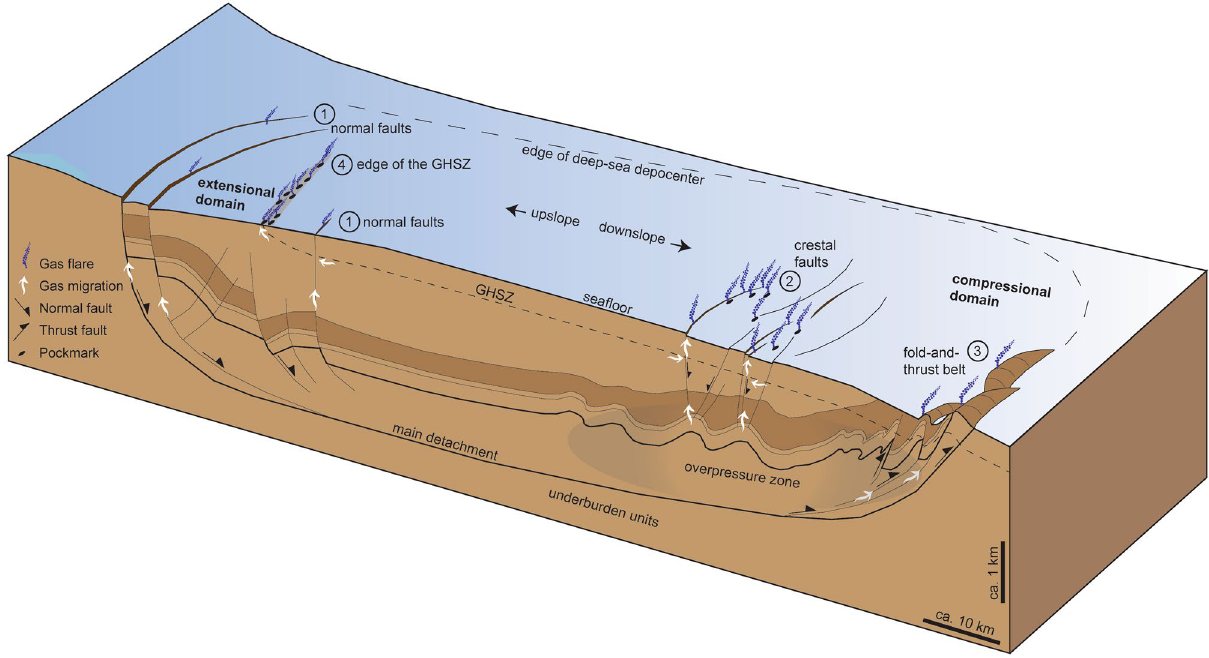
Figure 8. Schematic diagram summarising the probable loci of seafloor methane release associated with the gravitational collapse of sediment-laden continental slopes. Methane leakage occurs in both the extensional and compressional domains, preferentially at the intersection of the following structures with the seafloor: (1) listric normal faults in the extensional domain, (2) crestal faults on top of folds and (3) thrust and related strike- slip faults in the compressional domain. Another potential locus for seafloor methane emission, not related to gravitational collapse, is (4) the feather edge of the gas hydrate stability zone (GHSZ). The figure was elaborated in Adobe Illustrator (version 26.0.1; https:// www. adobe. com/ illus quantified by inspecting the video records and counting the number of bubbles venting out from the seafloor per unit of time 37 . The calculations assume no temporal variability of advective flux on timescales longer than the observed time (ca. 1 h). Measured bubble diameter was 0.5 cm and the quantity of methane n (moles) in each bubble was calculated based on the universal gas law (n = PV/ZRT), where P is pressure (13.5 MPa), V is the bub- ble volume (0.065 cm 3 ), Z is the compressibility of methane (0.7426) calculated by the Peng − Robinson equation of state 69 , R is the gas constant, and T is the bottom water temperature (3.25 °C). The mass of methane in each bubble was calculated based on the number of moles (obtained from the universal gas law) and the molar weight of methane. The emissions were then estimated based on the number of bubbles per unit of time. The bottom water temperature and pressure were obtained from a conductivity, temperature, depth (CTD Sea-Bird Electron- ics SBE 911plus) profile acquired in the area near PC83 (see Supplementary Data 3 and Fig. 4a for location). The CTD (temperature) data was also used to calculate the depth of the upper limit of the methane hydrate stability zone in the water column using the equilibrium equation of pure methane in seawater 70 . Chemical and isotopic composition of gas. Sediment samples (ca. 200 cm 3 ) were collected every 1.5 m in all piston cores for gas analyses. Samples were placed in gas-tight containers (Isojars), together with 200 cm 3 of distilled water and 10 drops of Zephiran Chloride bactericide. The remaining 200 cm 3 in the jar was left for the formation of headspace. Samples of gas hydrates were also added into jars. The chemical composition of headspace and gas bubbles collected in flares were determined using a Shimadzu gas chromatograph (GC) model GC-2014 equipped with a capillary column VP-Plot Alumina/KCl, 30 m × 0.53 mm, and flame ionisation detector. Helium was used as carrier gas (flow rate of 5 mL min −1 ) and the oven temperature was set to 200 °C. Carbon stable isotopic composition was determined with a GC (Thermo Scientific) coupled to an isotopic ratio mass spectrometer (Thermo Scientific DELTA-V Plus) via a Thermo GC IsoLink and Conflo IV interfaces. The GC has a 30 m × 0.32 mm fused silica column, Carboxen Plot 1006, and a heating ramp of 70–150 °C was set over 30 min. The isotopic ratio is reported using the delta notation (δ 13 C) relative to the international Vienna Pee Dee Belemnite standard (V-PDB). The radiogenic 14 C isotope analyses of methane were performed in the venting gas bubbles, gas in hydrates and gas in sediment pores using an accelerator mass spectrometry in the Beta Analytic laboratory in Florida, U.S.A. The modern reference standard was 95% the 14 C activity of the National Institute of Standards and Technology (NIST) Oxalic Acid (SRM 4990C) and calculated using the Libby carbon half-life (5568 years). Data availability All relevant data are included in the Supplementary material to this article.